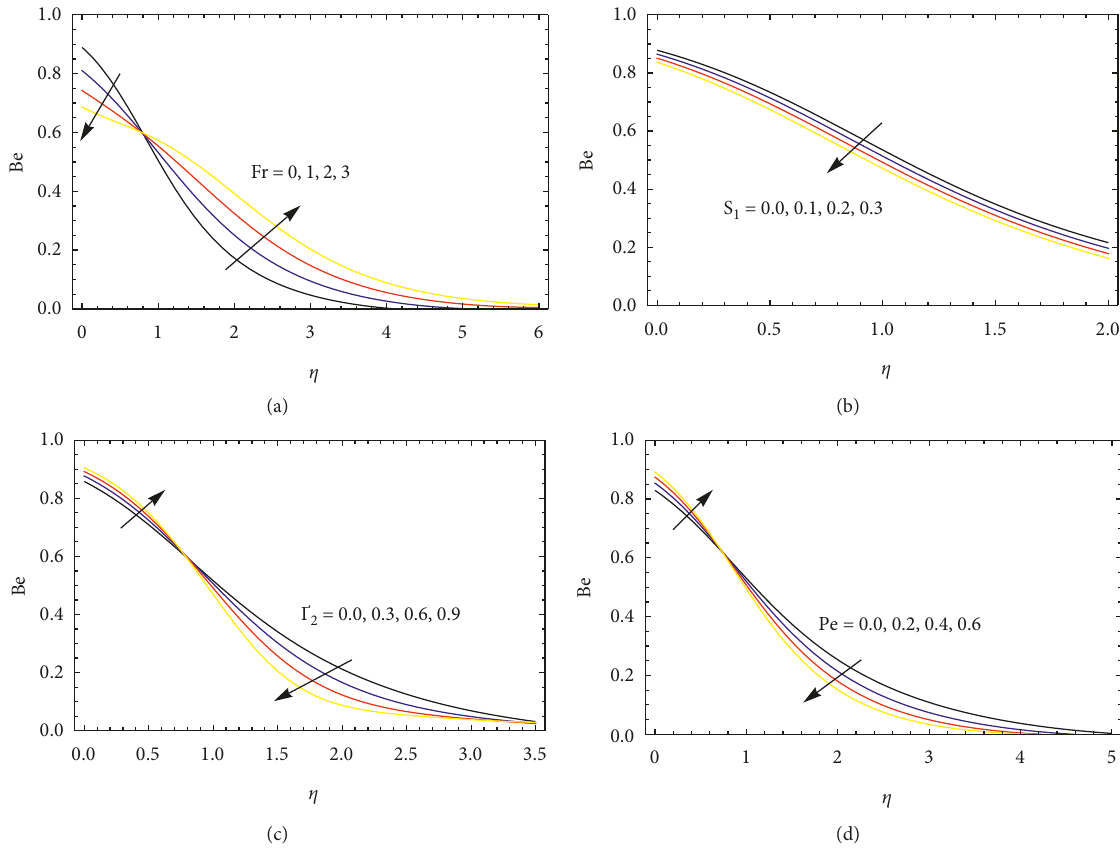
Figure 7: Bejan number profile for different values of Fr, S